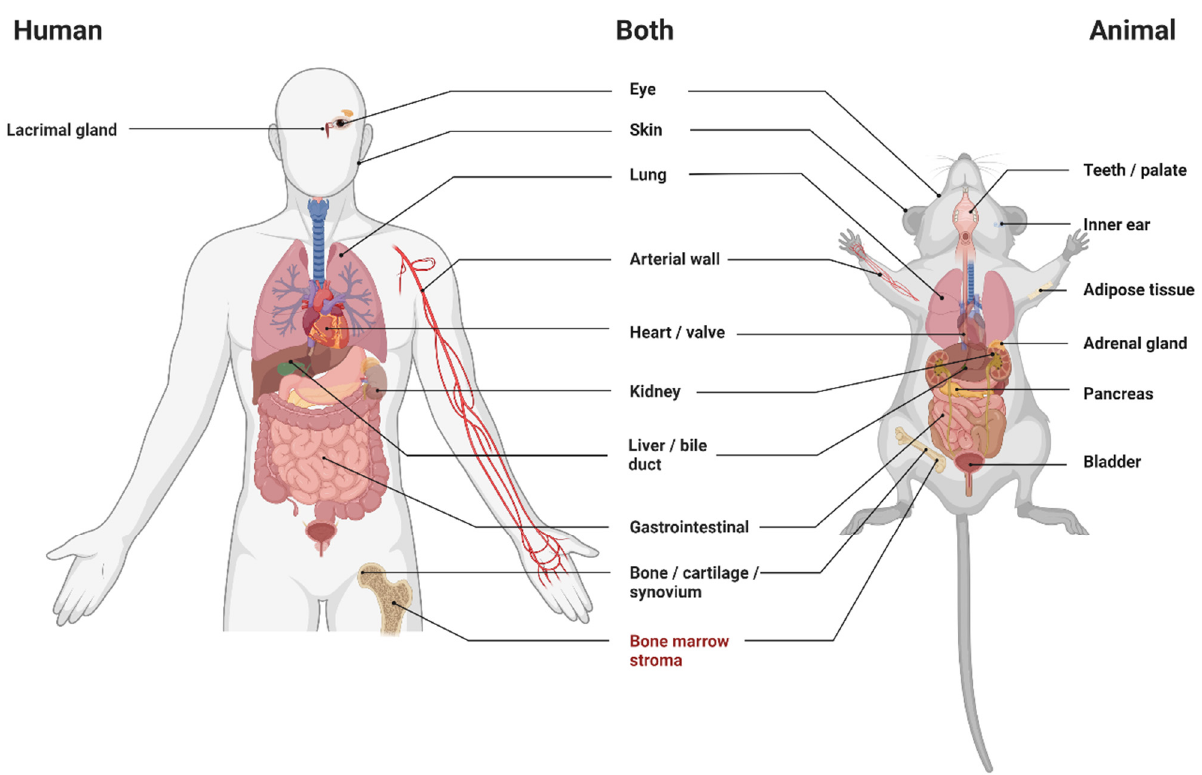
Figure 2. Tissues studied in included articles, by species. Black text = studies identified bone marrow-derived fibroblasts. Red text = studies did not identify bone marrow-derived fibroblasts. Created with BioRender.com.